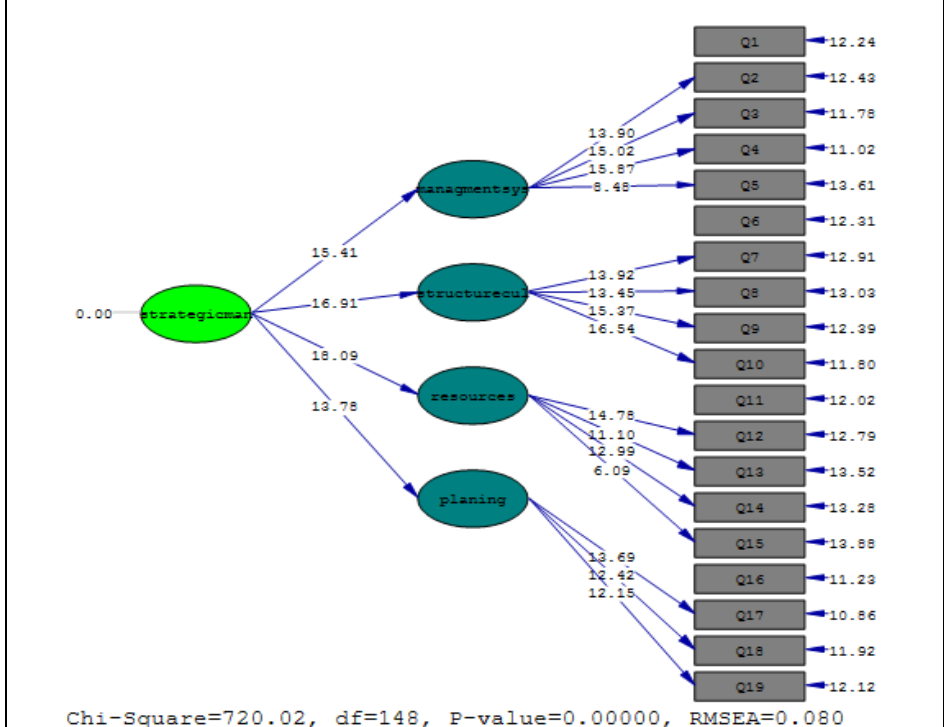
Figure 5 . Correlation